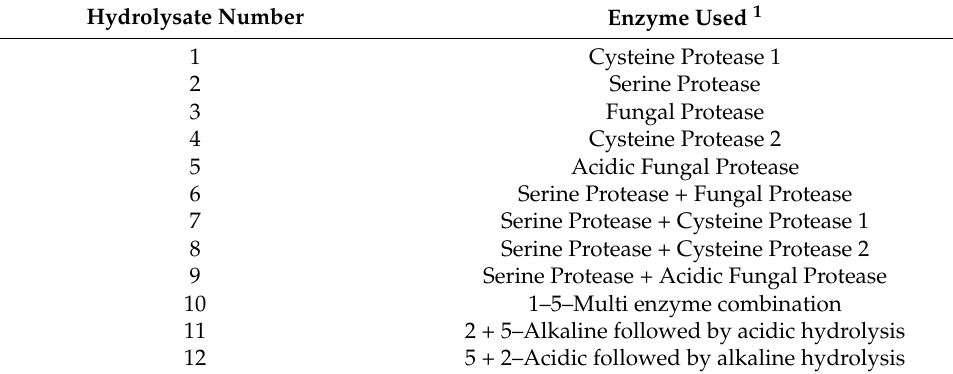
Table 1. Enzymes selected for protein hydrolyses. Hydrolysate Number Enzyme Used